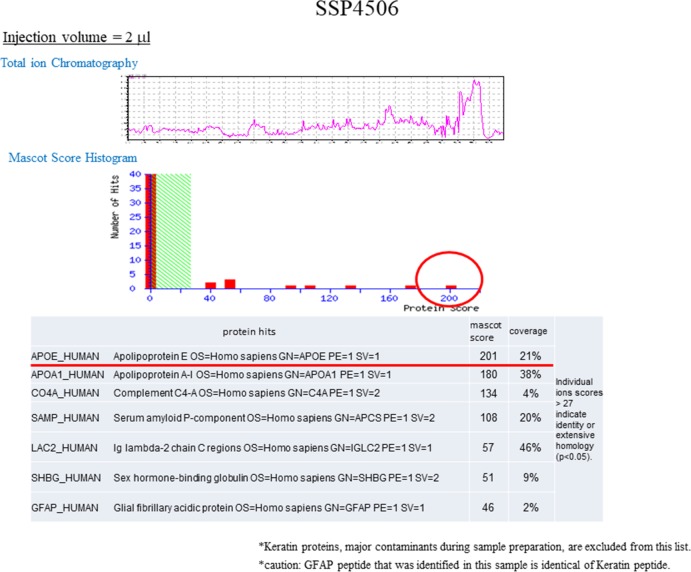
Representative Tandem mass spectrometric analysis of a 2-DE gel spot (SSP4506) showing statistically significant differences in spot intensity between the attack-free period and the attack period of migraineurs.(Upper panel) Total Ion Chromatogram of tryptic digest from SSP4506. (Middle panel) Mascot histogram of the score distribution for the proteins identified in SSP4506. (Lower Table) ApoE and another six proteins were identified as having significant Mascot scores (>28) in SSP4506.